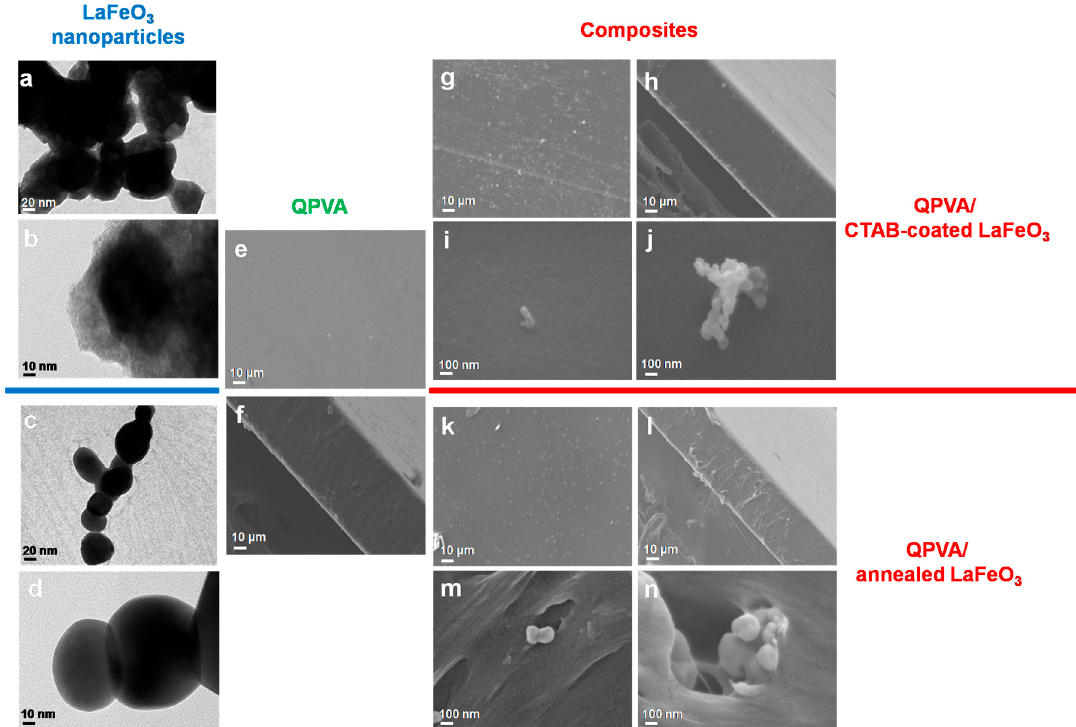
Figure 1. Transmission electron microscope (TEM) and high-resolution TEM (HRTEM) images of LaFeO 3 nanoparticles of: ( a , b ) cetyltrimethylammonium bromide (CTAB)-coated; ( c , d ) 800 °C annealed samples, and field emission scanning electron microscope (FESEM) surface and cross-sectional morphology of: ( e , f ) quaternized poly(vinyl alcohol) (QPVA) membrane; ( g – j ) QPVA/CTAB-coated LaFeO 3 ; and ( k – n ) QPVA/annealed LaFeO 3 nanocomposite membrane.